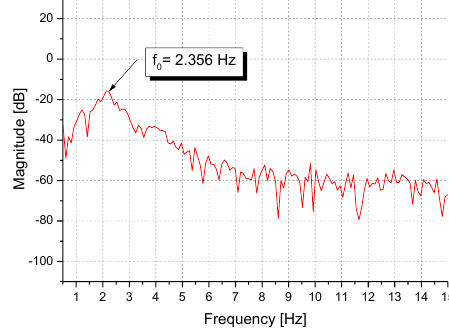
Fig. 8. Frequency response of the vibro-isolating